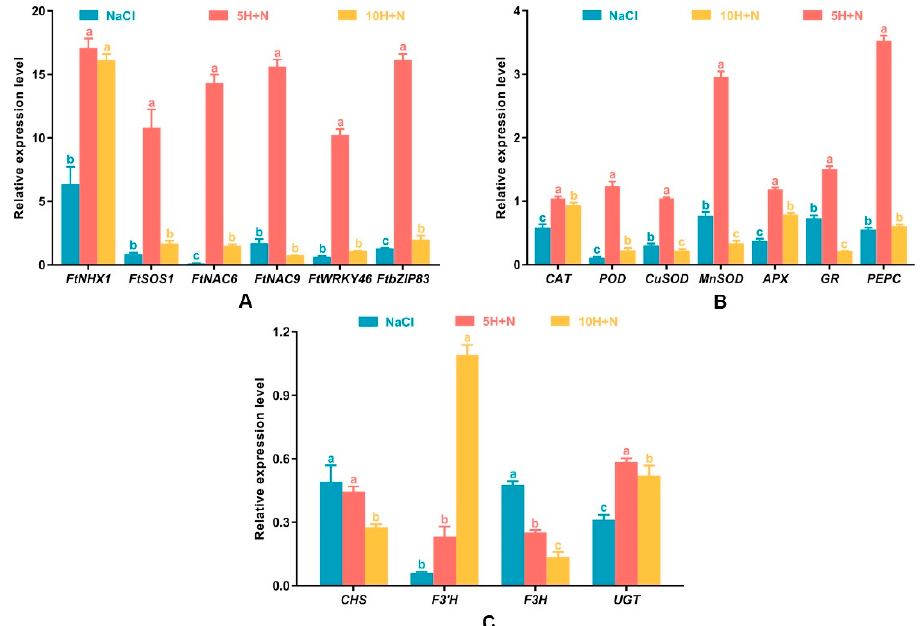
Figure 8. Effects of exogenous H 2 O 2 on the relative expression levels of stress-related genes ( FtNHX1 , FtSOS1 , FtNAC6 , FtNAC9 , FtWRKY46 , and FtbZIP8 ) ( A ), enzyme-related genes ( CAT , POD , CuSOD , MnSOD , APX , GR , and PEPC ) ( B ), key genes ( CHS , F3 ′ H , F3H , and UGT ) in the fla- vonoid synthesis pathway ( C ) of Tartary buckwheat under NaCl stress. NaCl: H 2 O foliar spray + 150 mmol·L − 1 NaCl irrigation, 5H + N: 5 mmol·L − 1 H 2 O 2 foliar spray + 150 mmol·L − 1 NaCl irrigation, 10H + N: 10 mmol·L − 1 H 2 O 2 foliar spray + 150 mmol·L − 1 NaCl irrigation. All values are expressed as mean ± SD. According to Duncan’s multiple comparisons, different letters represent significant differences among different treatments ( p <